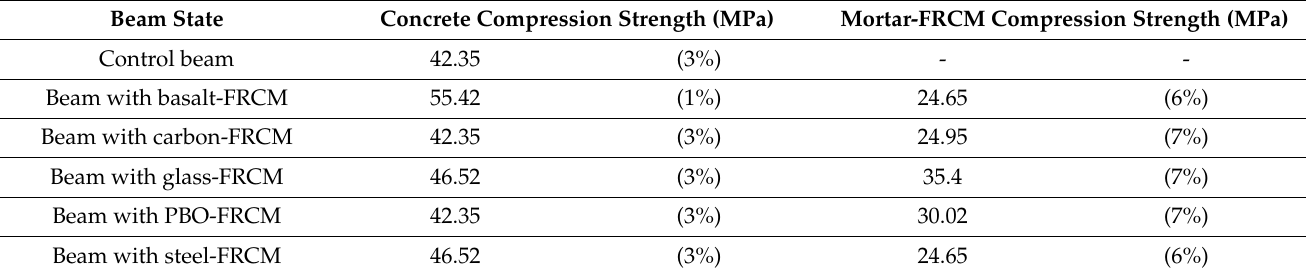
Figure 1. Geometry and steel reinforcement of the beams. Table 1. Concrete and mortar properties.